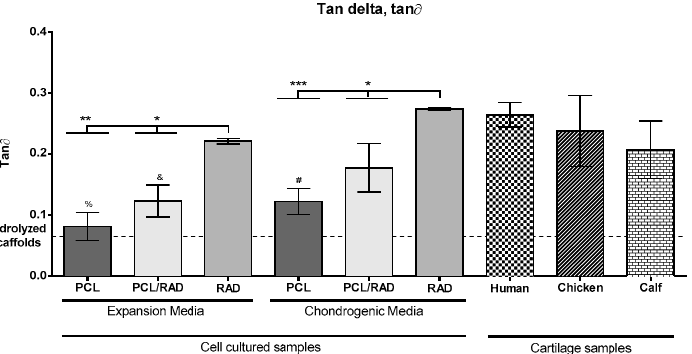
Figure 4. Mechanical properties characterization of PCL, PCL/RAD and RAD constructs under expansion or chondrogenic media culture for 30 days. Tan Delta (tan ∂ ), % stands for statistical differences compared to human (****), chicken (***) and calf (**), and stands for statistical differences with human (**) and chicken (**), # stands for statistical differences with human (**) and chicken (**). Small pieces of human, chicken and calf articular cartilage were measured in the same conditions (Statistical differences are indicated as: * p < 0.05, ** p < 0.01 and *** p < 0.001 one-way ANOVA). n = 3.